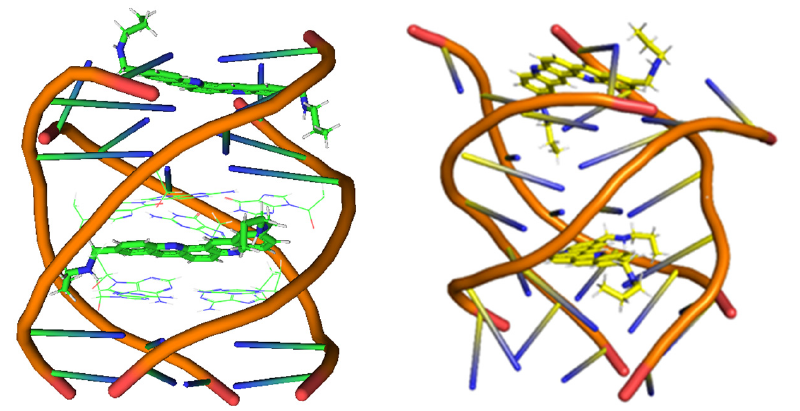
Figure 28. Structures of the GQ obtained from the Protein Data Bank, PDB ID: 2jwq, ( left ) and structure obtained from the optimization with the QM/MM approach at M11-L/6-31+G(d,p):UFF level ( right ).